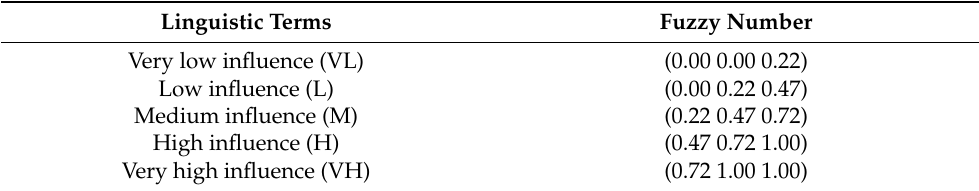
Table 2. Linguistic terms and fuzzy numbers for assessing the degree of